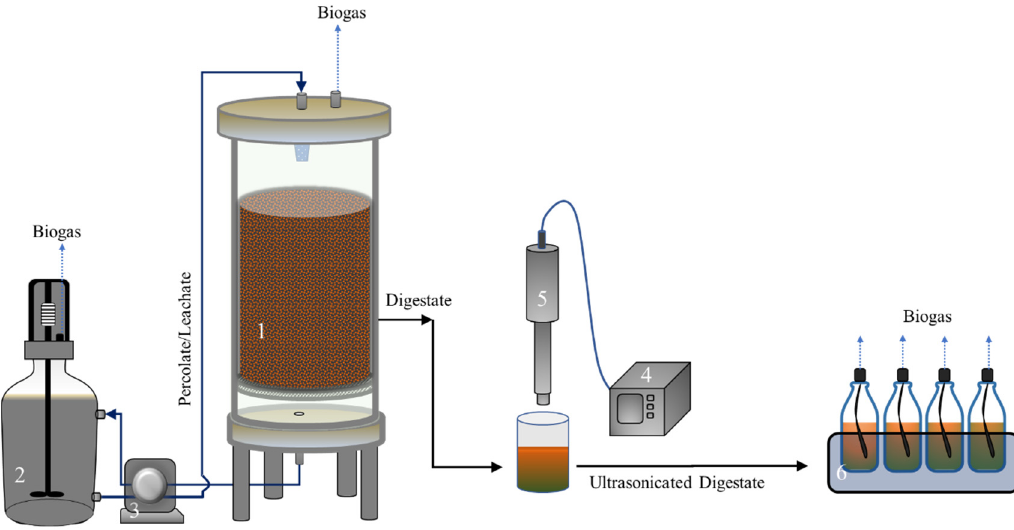
Figure 1. Schematic diagram of experimental setup. Notes: (1) digester tank; (2) percolate/leachate tank; (3) pump; (4) ultrasound generator; (5) ultrasonic probe; (6) batch anaerobic bioreactor system.